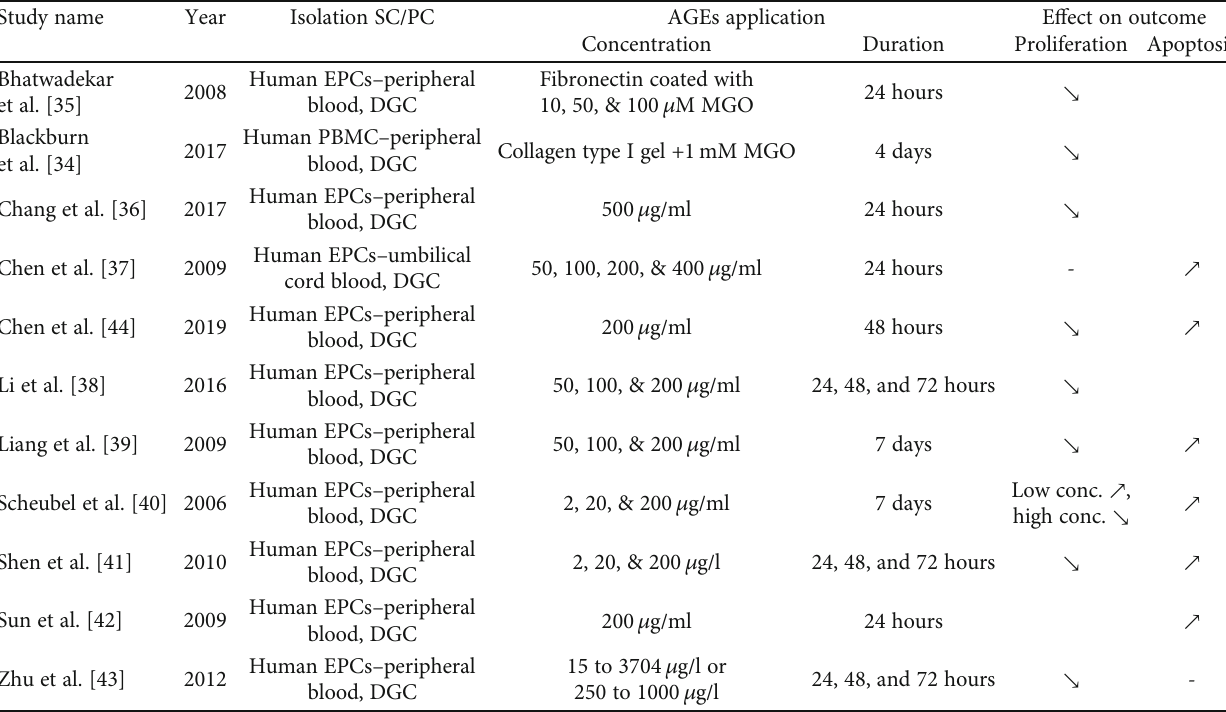
Table 1: Summary of included studies using BDSCs. Summary of isolation procedure and sampling, AGEs concentration, application duration, and e ff ect on outcome measurement proliferation and apoptosis.